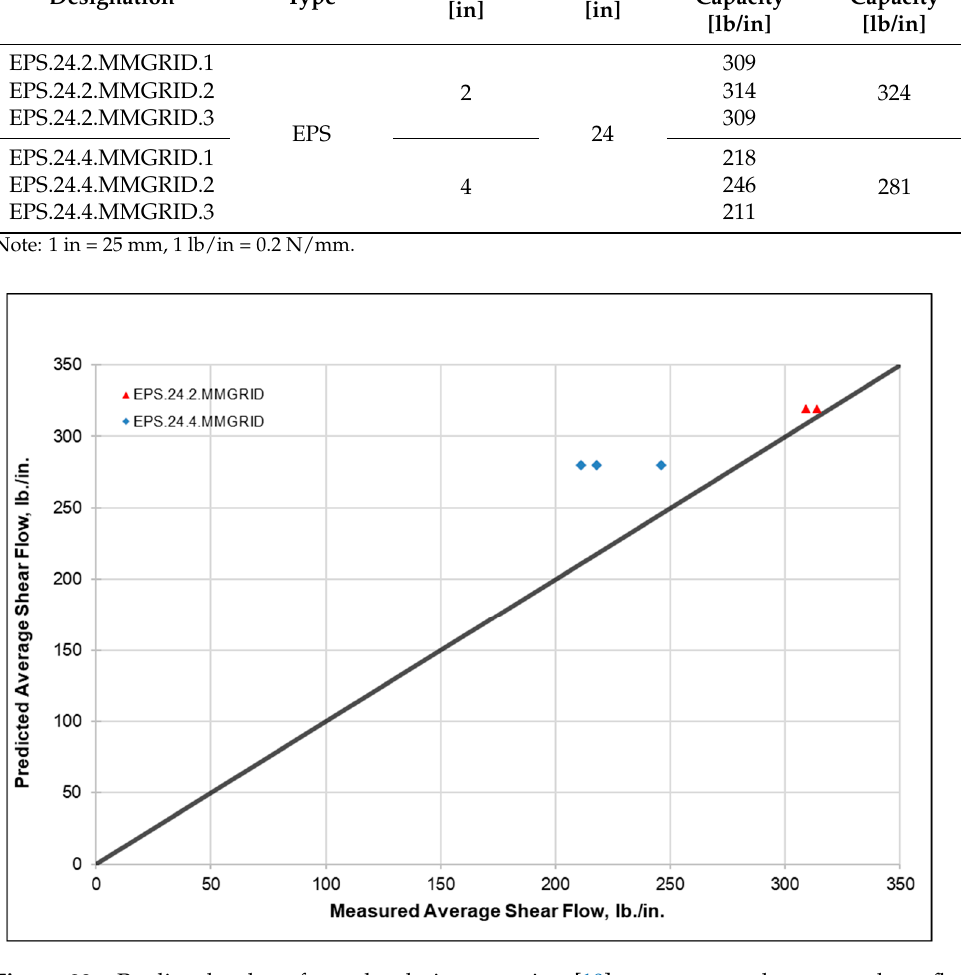
Figure 23. Predicted values from the design equation [10] vs. measured average shear fl ow (1 lb/in = 0.2 N/mm).